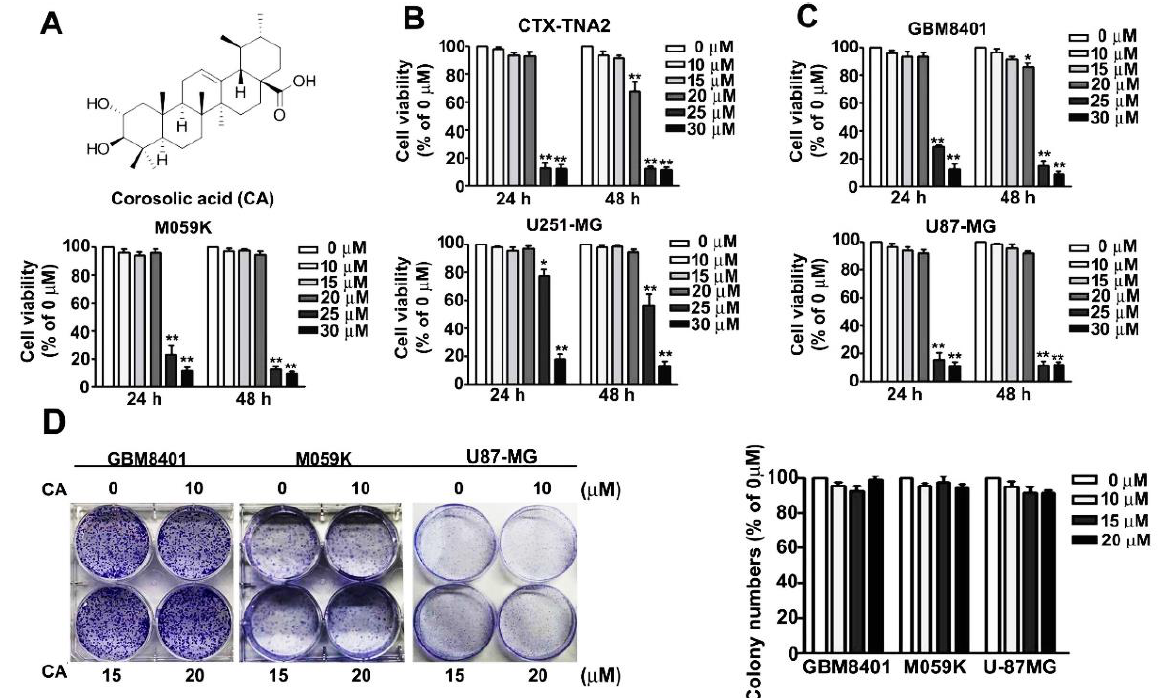
Figure 1. Effect of CA on cell viability and colony formation of GBM cells. ( A ) Structure of CA. ( B , C ) Normal astrocyte, CTX-TNA2 and GBM cell lines, GBM8401, M059K, U251-MG and U87-MG, were treated with CA at the indicated concentrations for 24 or 48 h. Then, cell viability was assessed by MTT assay and presented as a percentage of control. ( D ) GBM8401, M059K and U87-MG were seeded onto cell culture dishes containing without or with CA at 10, 15 and 20 μ M for 7 days, and then cell colonies were stained with Giemsa and counted using a light micro-scope. Three independent experiments were performed for statistical analysis. * p < 0.05; ** p < 0.01 compared with control (DMSO-treated cells).